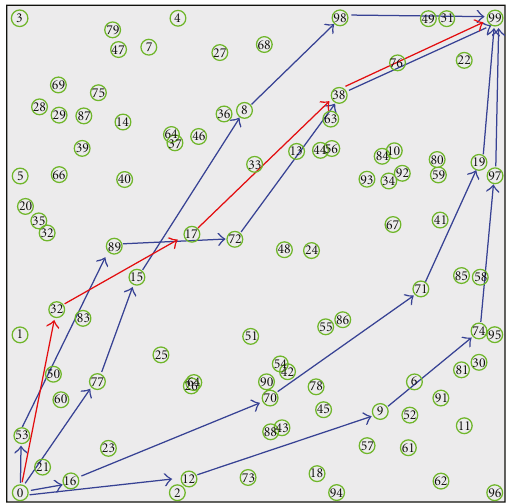
Figure 4: A snapshot of the network before applying the Routing Protocol.